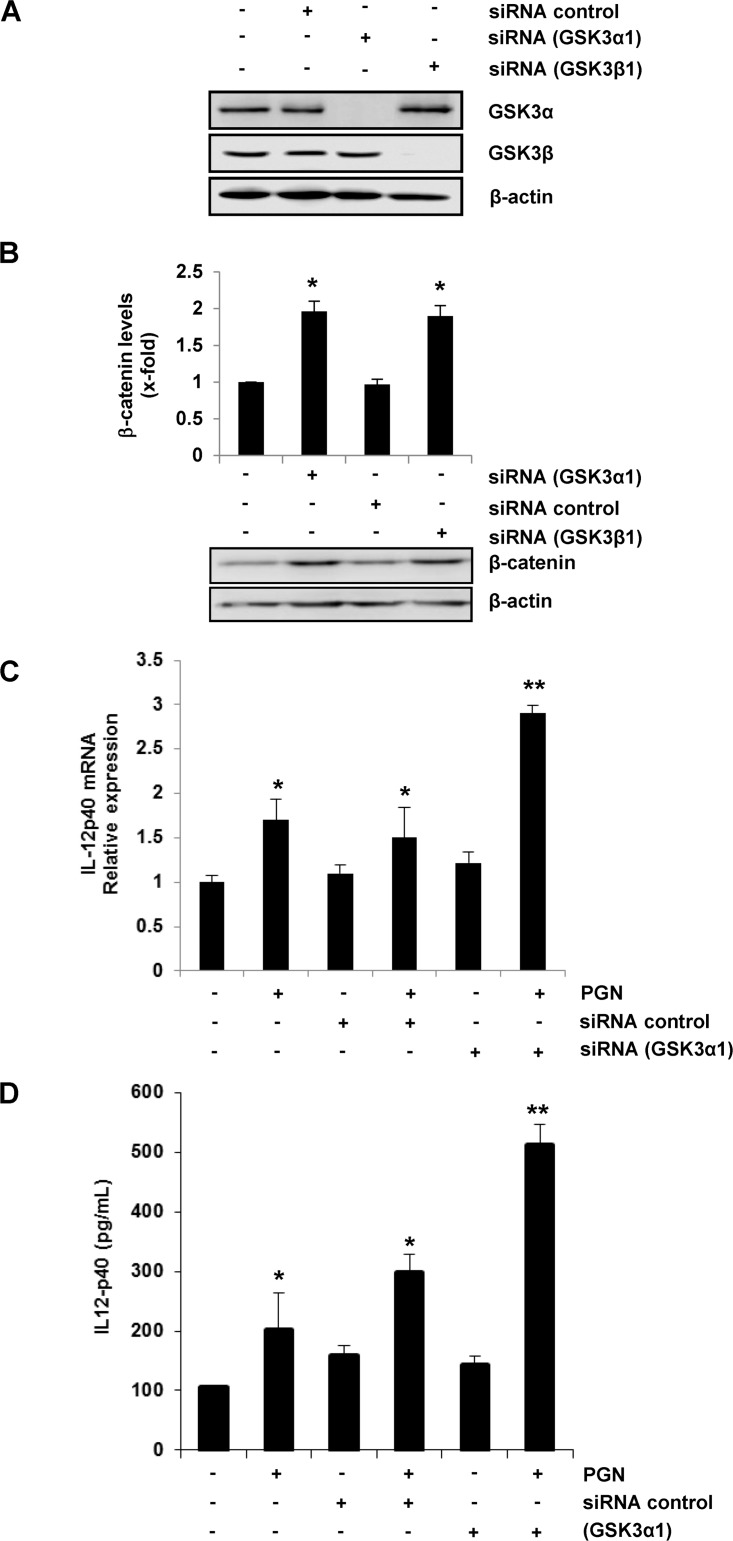
GSK3α inhibition up-regulates IL-12p40 expression in BEC stimulated with PGN.A) BEC were left untransfected (-), transfected with control siRNA (siRNA control), transfected with siRNA targeting GSK3α (siRNA GSK3α1) or transfected with siRNA targeting GSK3β (siRNA GSK3β1). B) BEC were left untransfected and unstimulated (-), stimulated with 10 μg/mL of PGN for 4 h, transfected with control siRNA (siRNA control), transfected with control siRNA and then stimulated with 10 μg/mL PGN for 4 h, transfected with siRNA targeting GSK3α (siRNA GSK3α1) or transfected with siRNA targeting GSK3α (siRNA GSK3α1) and then stimulated with 10 μg/mL of PGN for 4 h. C) BEC were left untransfected and unstimulated (-), stimulated with 10 μg/mL of PGN for 9 h, transfected with control siRNA (siRNA control), transfected with control siRNA and then stimulated with 10 μg/mL of PGN for 9 h, transfected with siRNA targeting GSK3α (siRNA GSK3α1) or transfected with siRNA targeting GSK3α1 and then stimulated with 10 μg/mL of PGN for 9 h. Protein extracts were analyzed by western blot and probed with a monoclonal antibody against the phosphorylated forms of GSK3α and GSK3β (A). To verify that equal amount of proteins was loaded in each lane, blots were stripped and reprobed with an antibody that recognizes the nonphosphorylated form of β-actin (A). Blots are representative of three independent experiments. Total RNA was extracted and relative transcript level of IL-12p40 was quantitated by qRT-PCR, using the delta-delta Ct method and amplification of β-actin as a reference gene (B). Cell-free supernatants were analyzed by ELISA for production of IL-12p40 (C). Results are expressed as the mean ± S.E.M. (n = 3). *p <0.05; **p <0.01. All data were compared with the untreated and untransfected controls.